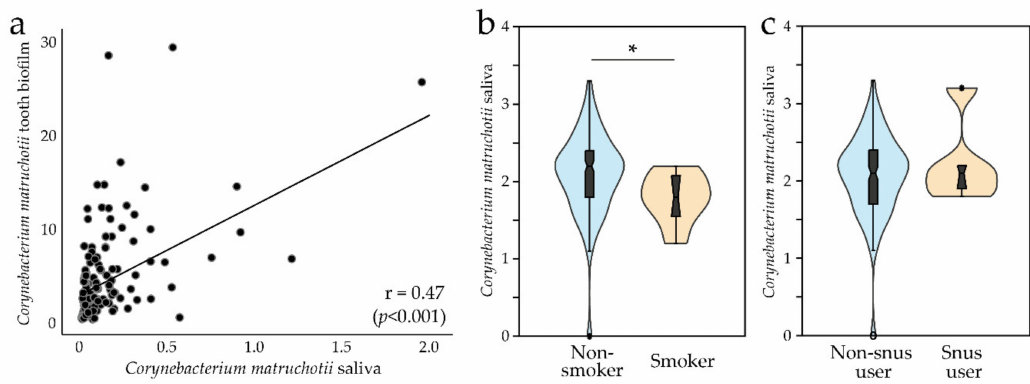
Figure 1. ( a ) Scatter plot of C. matruchotii abundance in saliva versus tooth biofilm. ( b ) Violin plots with a box plot comparing C. matruchotii abundance in saliva by smoking and ( c ) use of Swedish snus (snu ff ). * p <